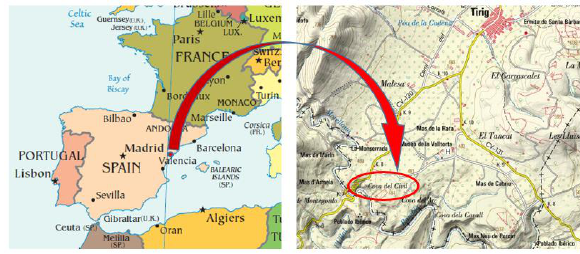
Figure 6. Location map of Cova Civil rock art site